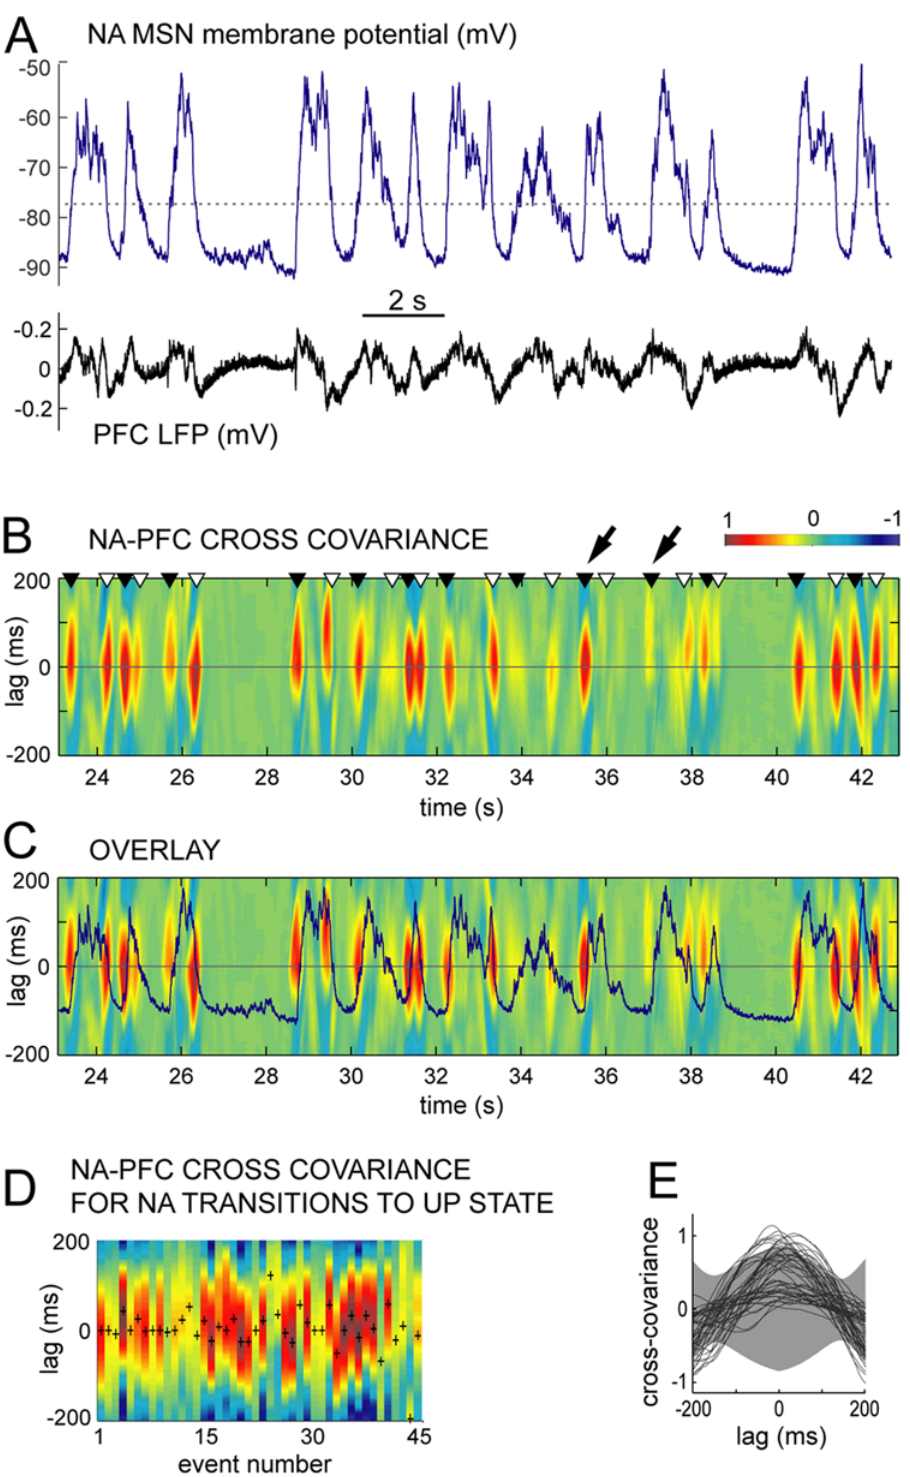
Figure 5. Cross-covariance analysis of intracellular NA neuron membrane potential and PFC LFP in anesthetized rats. (A) Simultaneous recording of intracellular membrane potential of a NA medium spiny neuron (MSN; top) and PFC field potential (LFP; bottom) showing spontaneous oscillations typical of an anesthetized rat. Transitions of MSN membrane potential between a hyperpolarized down state and depolarized up states are detected with a threshold (dotted line). (B) Pseudocolor plot of the cross covariance of these traces with a 6 200 ms time lag window (ordinate). MSN membrane potential transitions from down to up states are indicated by dark triangles, and up-to-down transitions with white triangles. Oblique arrows point to two consecutive up state onsets showing high covariance (left) and no covariance (right) with PFC LFP. (C) Overlay of the cross covariance plot in B and the MSN membrane potential trace in A showing the high covariance epochs to correspond to state transitions. (D) Cross covariance at successive down-to-up state transitions from data in A, showing that both the magnitude and lag of the peak